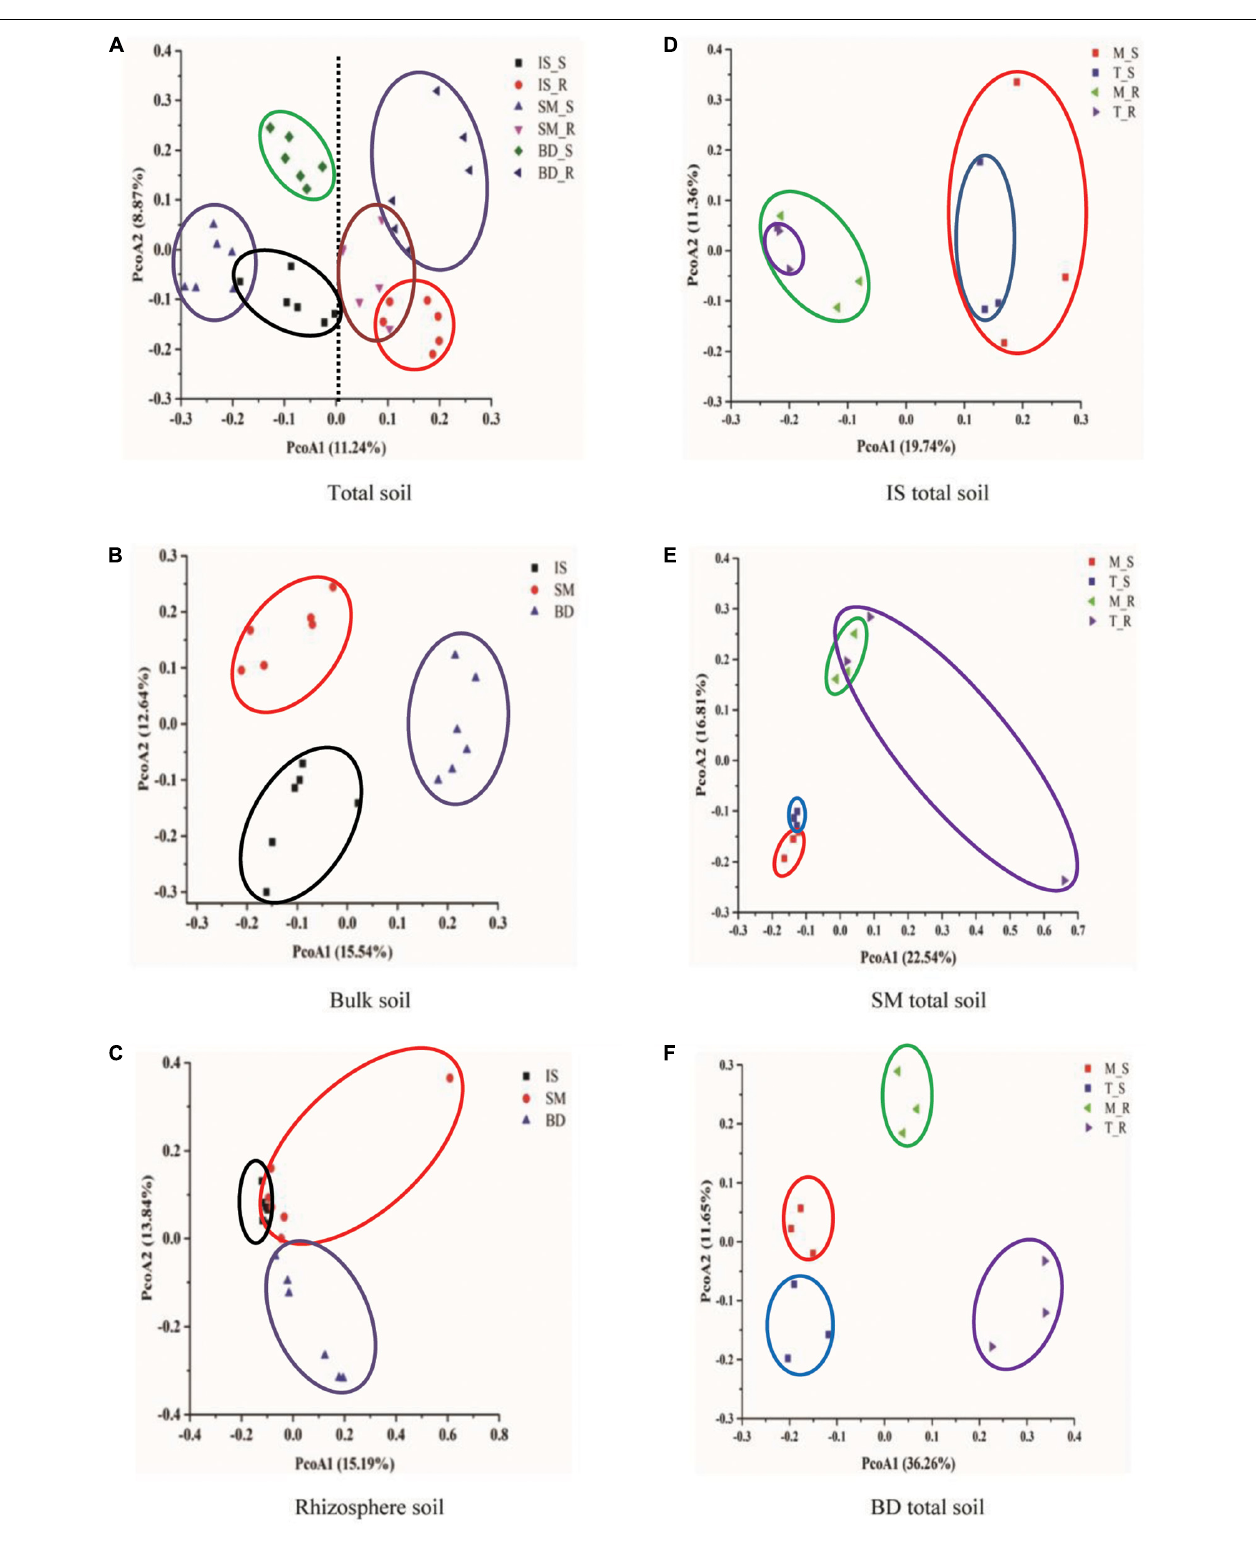
FIGURE 4 | PCoA plot of soil bacterial community composition. (A) For total soil, (B) for bulk soil, (C) for rhizosphere soil, (D) for IS total soil, (E) for SM total soil, and (F) for BD total soil. Sites: IS, middle of glacier terminal and small Qiangyong lake; SM, midway along the edge of the smaller lake; BD approximately one-third of the way along the edge of the larger lake. M and T indicate the sampling lines, Middle and Top, respectively; S and R represent bulk and rhizosphere soils, respectively.